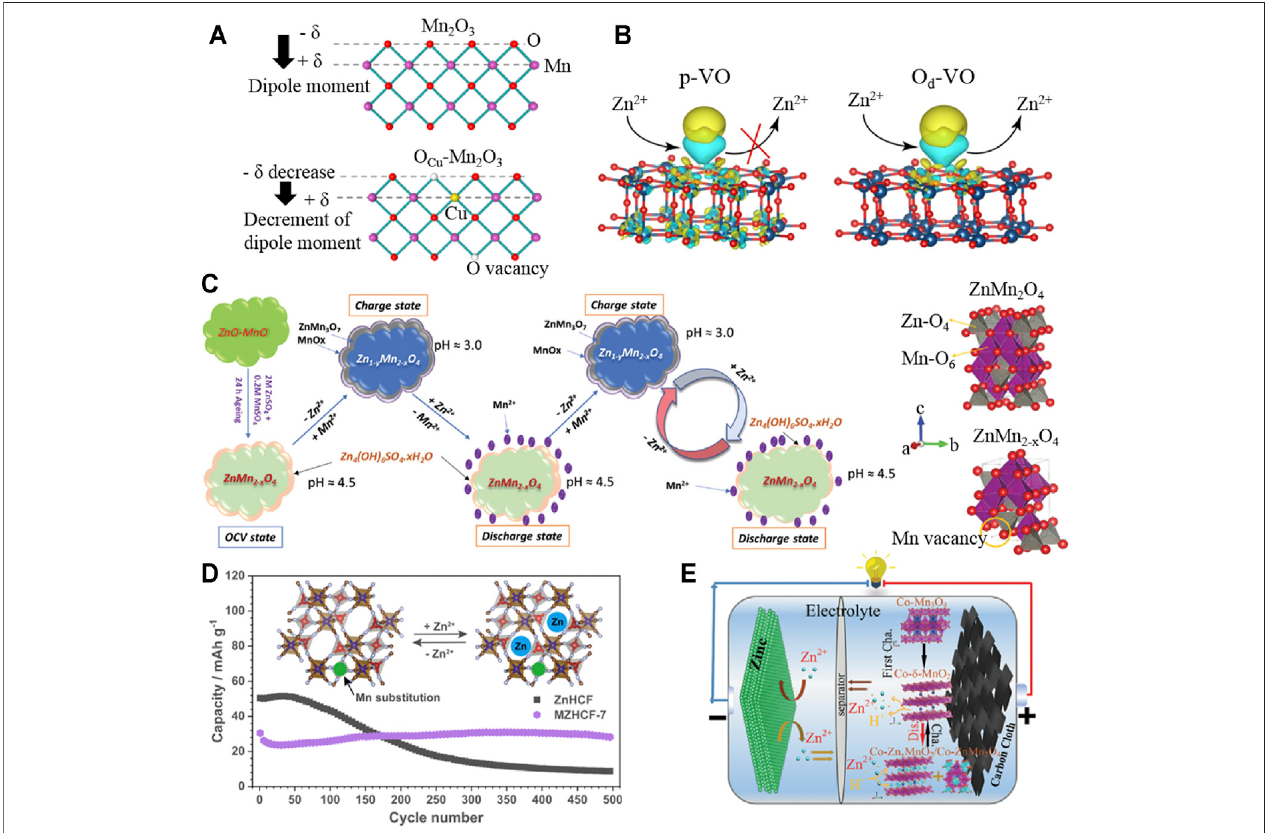
FIGURE 1 | Vacancies and doping modi fi cation of cathode materials. (A) Atomic structure models of a single layer height in Mn 2 O 3 and O cu -Mn 2 O 3 , respectively; (B) illustrations of the Zn 2+ storage/release for p-VO and O d -VO; (C) schematic illustration for the reaction mechanism of the in situ formed Zn/Mn-d-ZMO@C; (D) schematicdiagramofthereactionmechanismofMZHCFs; (E) schematicillustrationofZn||Co-Mn 3 O 4 /CANbattery.Reproducedwithpermission(Liuetal.,2020a;Liao et al., 2020; Islam et al., 2021; Ji et al., 2021; Ni et al.,